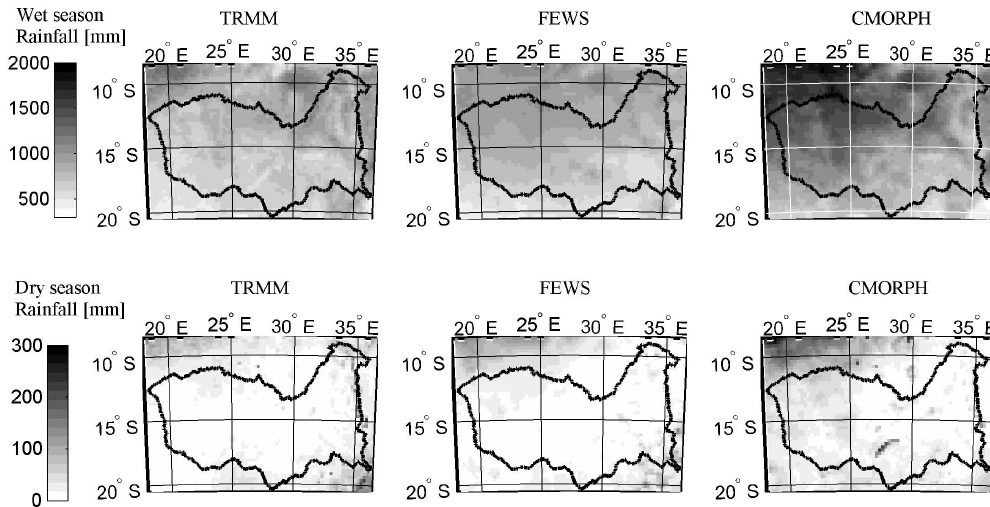
Fig. 2. Mean seasonal rainfall map for wet (top panels) and dry (bottom panels) periods for the three satellite estimates. Data analyzed from January 2003 to December